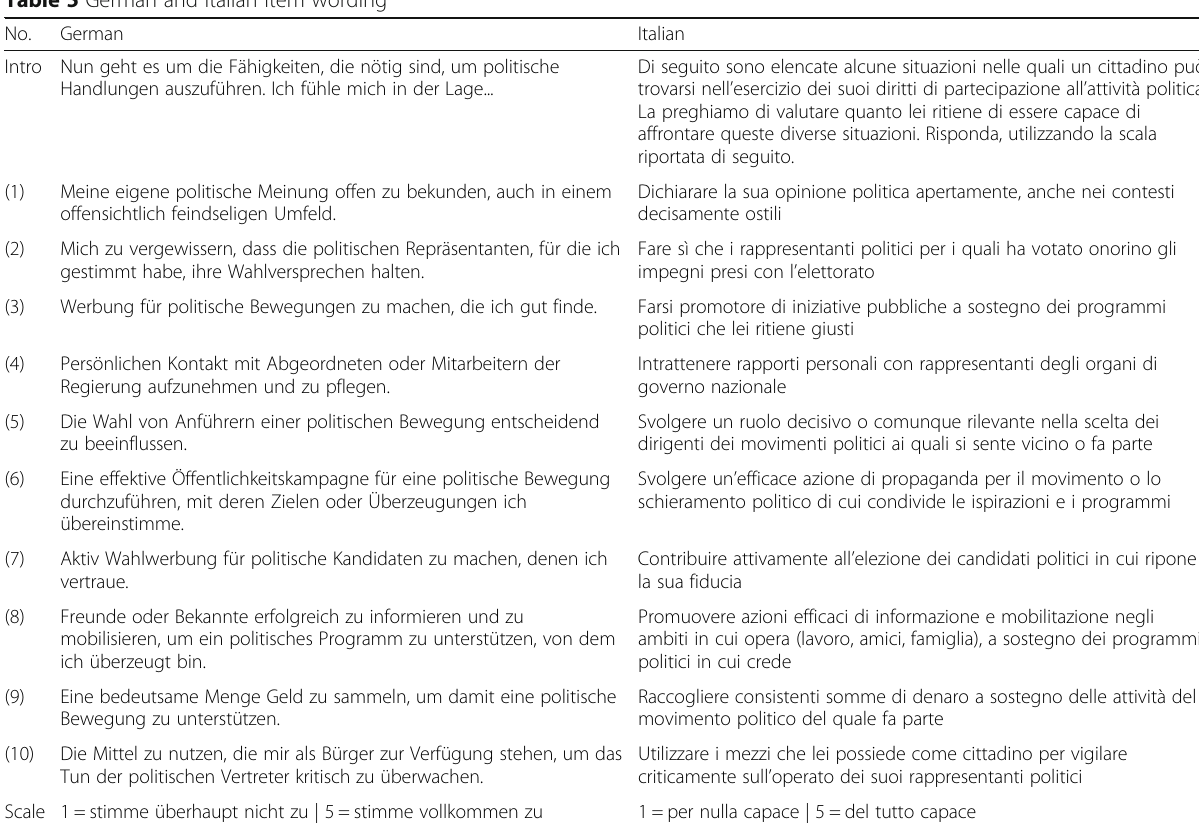
Table 5 German and Italian item